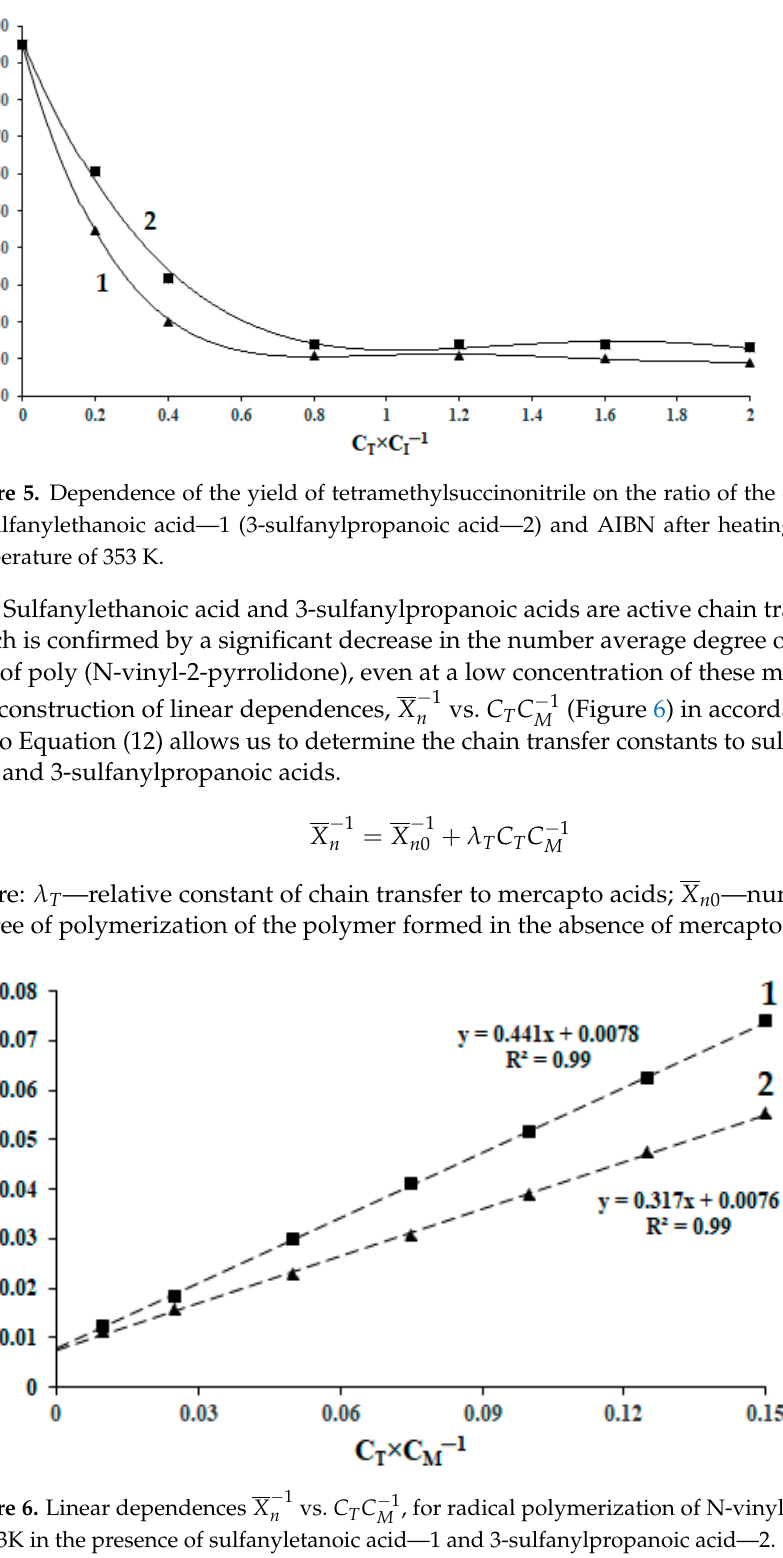
= 0.441 ), (cid:3021) values are con- (cid:3021)